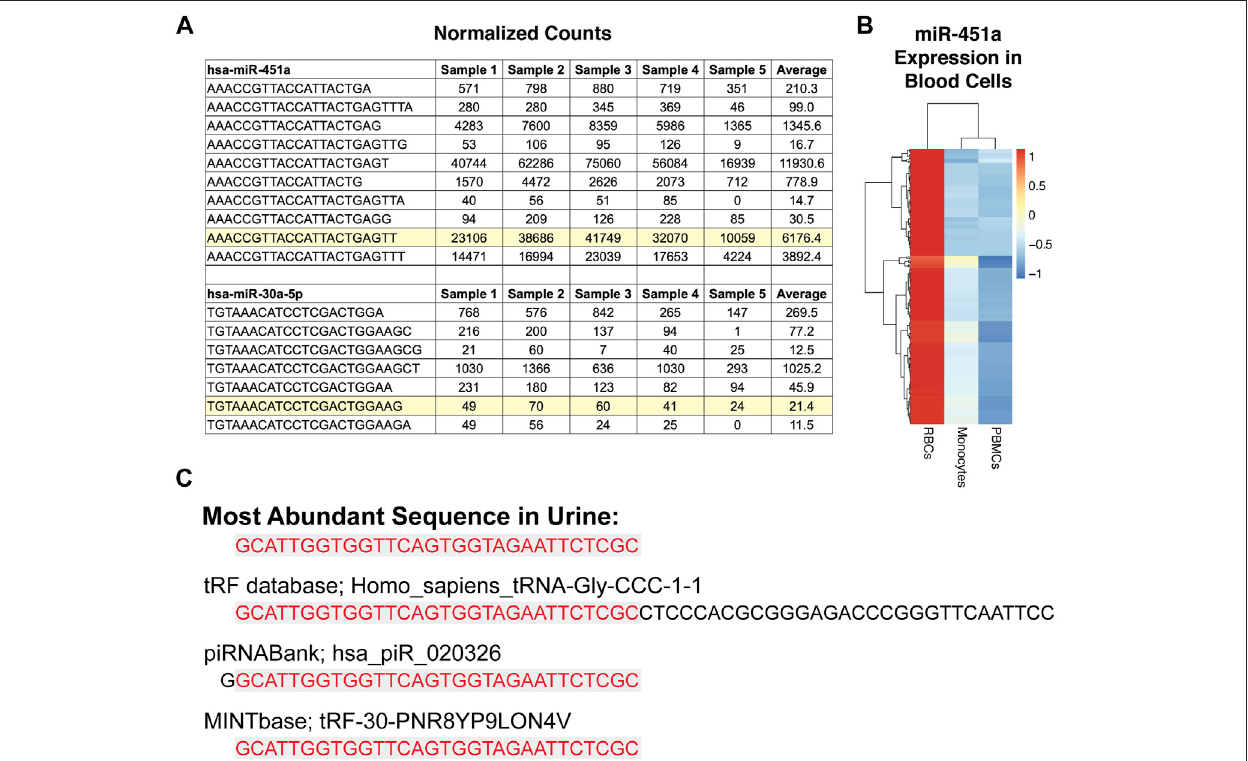
FIGURE3| SequenceVariationandCategorization.Panel (A) highlightsthecanonicalmiRNAsequencethatisenteredinmiRbasefortwomiRNAs,miR-451aand miR-30a-5p. The other sequences are isomiRs of the mature sequence (highlighted) listed in miRbase. The table shows the normalized expression for the sequences in plasma from fi ve different subjects and the average across the 179 cell-free plasma samples. In some cases, an isomiR has higher expression in plasma than the highlighted canonical sequence. miR-451a is highly expressed in red blood cells, as can be seen in the heat map in Panel (B) . Panel (B) displays the canonical and isomiRsequencesformiR-451afoundinredbloodcells,PBMCs,andmonocytes.ThemostabundantsequencedetectedinurinesamplesisdisplayedinFigure3cand is = similar to both a piRNA and a tRNA sequence.